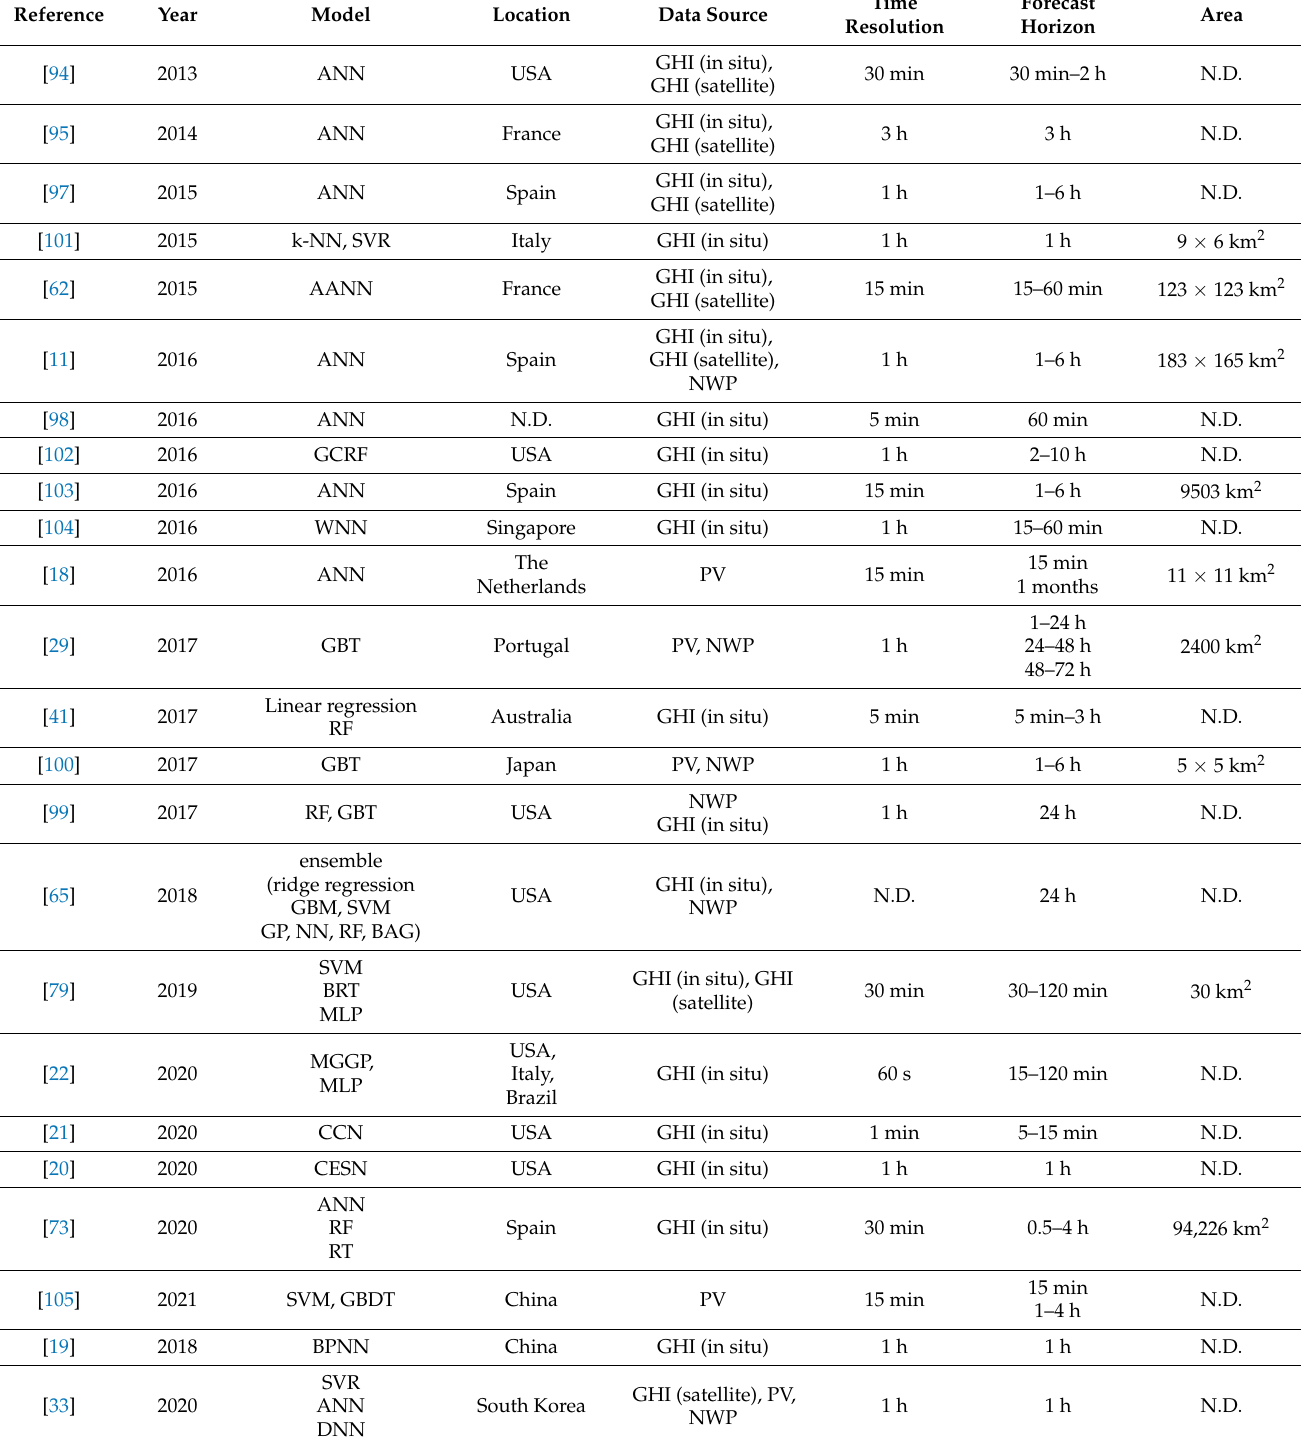
Table 3. Summary of available literature (2013–2021) for the application of traditional machine learning methods regarding spatio-temporal solar forecasting